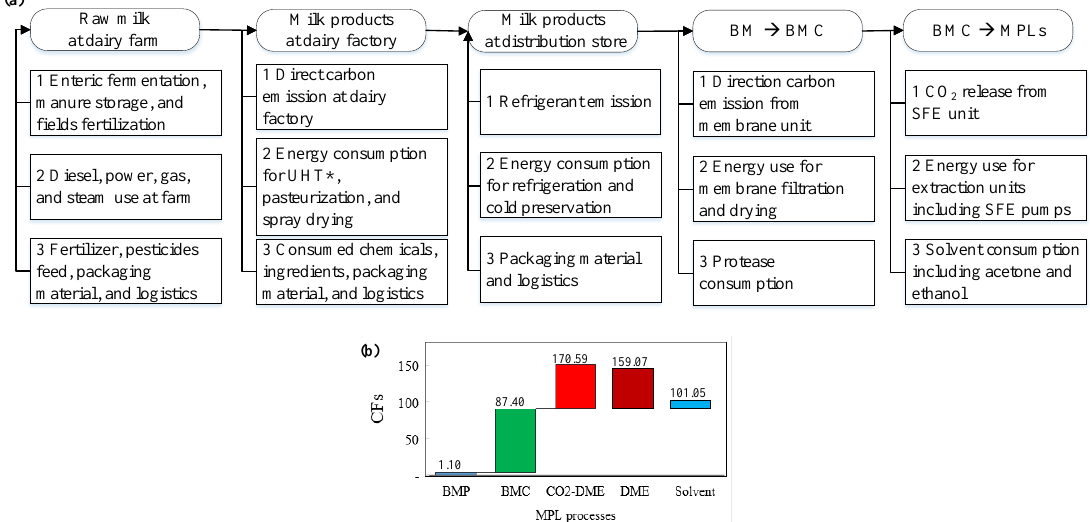
Figure 5. ( a ) Boundary definition of the life-cycle carbon footprints (CFs) of dairy products and exemplary emissions from scope 1 (direction emission), scope 2 (energy carriers), and scope 3 (raw material procured, packaging material, and transportation). ( b ) Cascade of CFs of BMP, BMC, and MPLs using the following processes: “CO 2 - DEM” (superc ritical CO 2 and DME), “DME” (supercritical DME), and